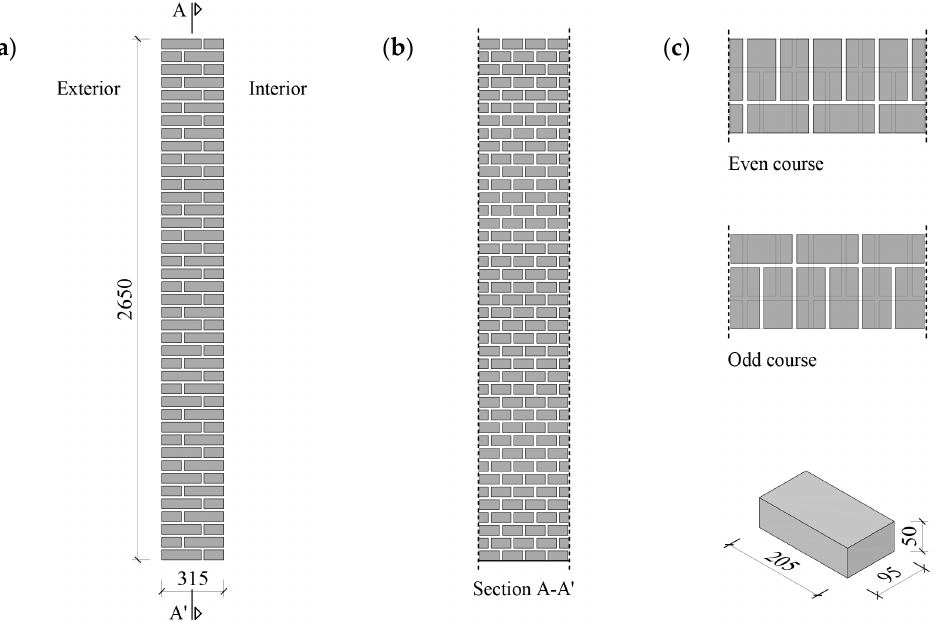
Figure 2. Schematic geometrical configuration of the brick masonry wall: ( a ) transversal cross-section; ( b ) vertical cross-section; ( c ) bond arrangement and geometry of the brick units. Dimensions in mm.